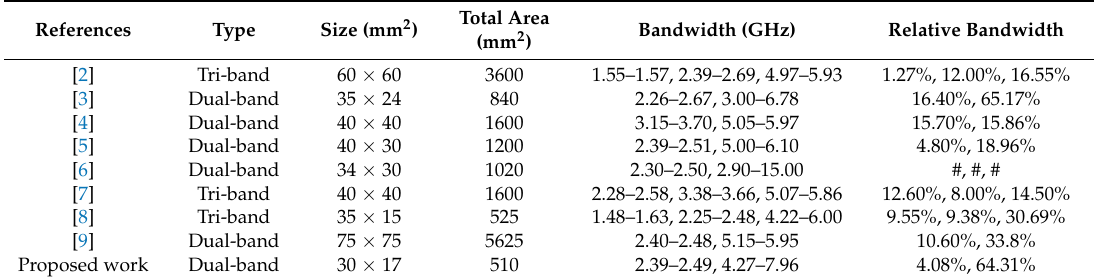
Table 1. Comparison of microstrip multi-band